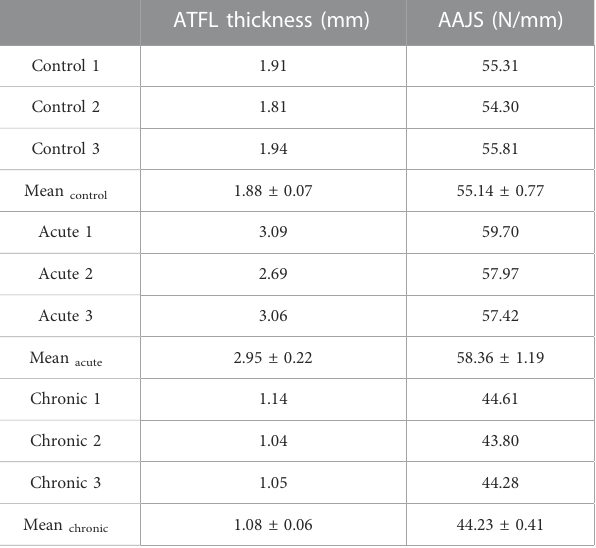
TABLE 5 Thickness of ATFL and AAJS of the